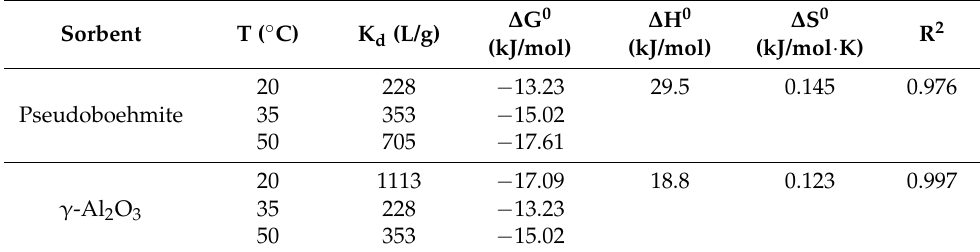
Table 7. Results from thermodynamic parameters